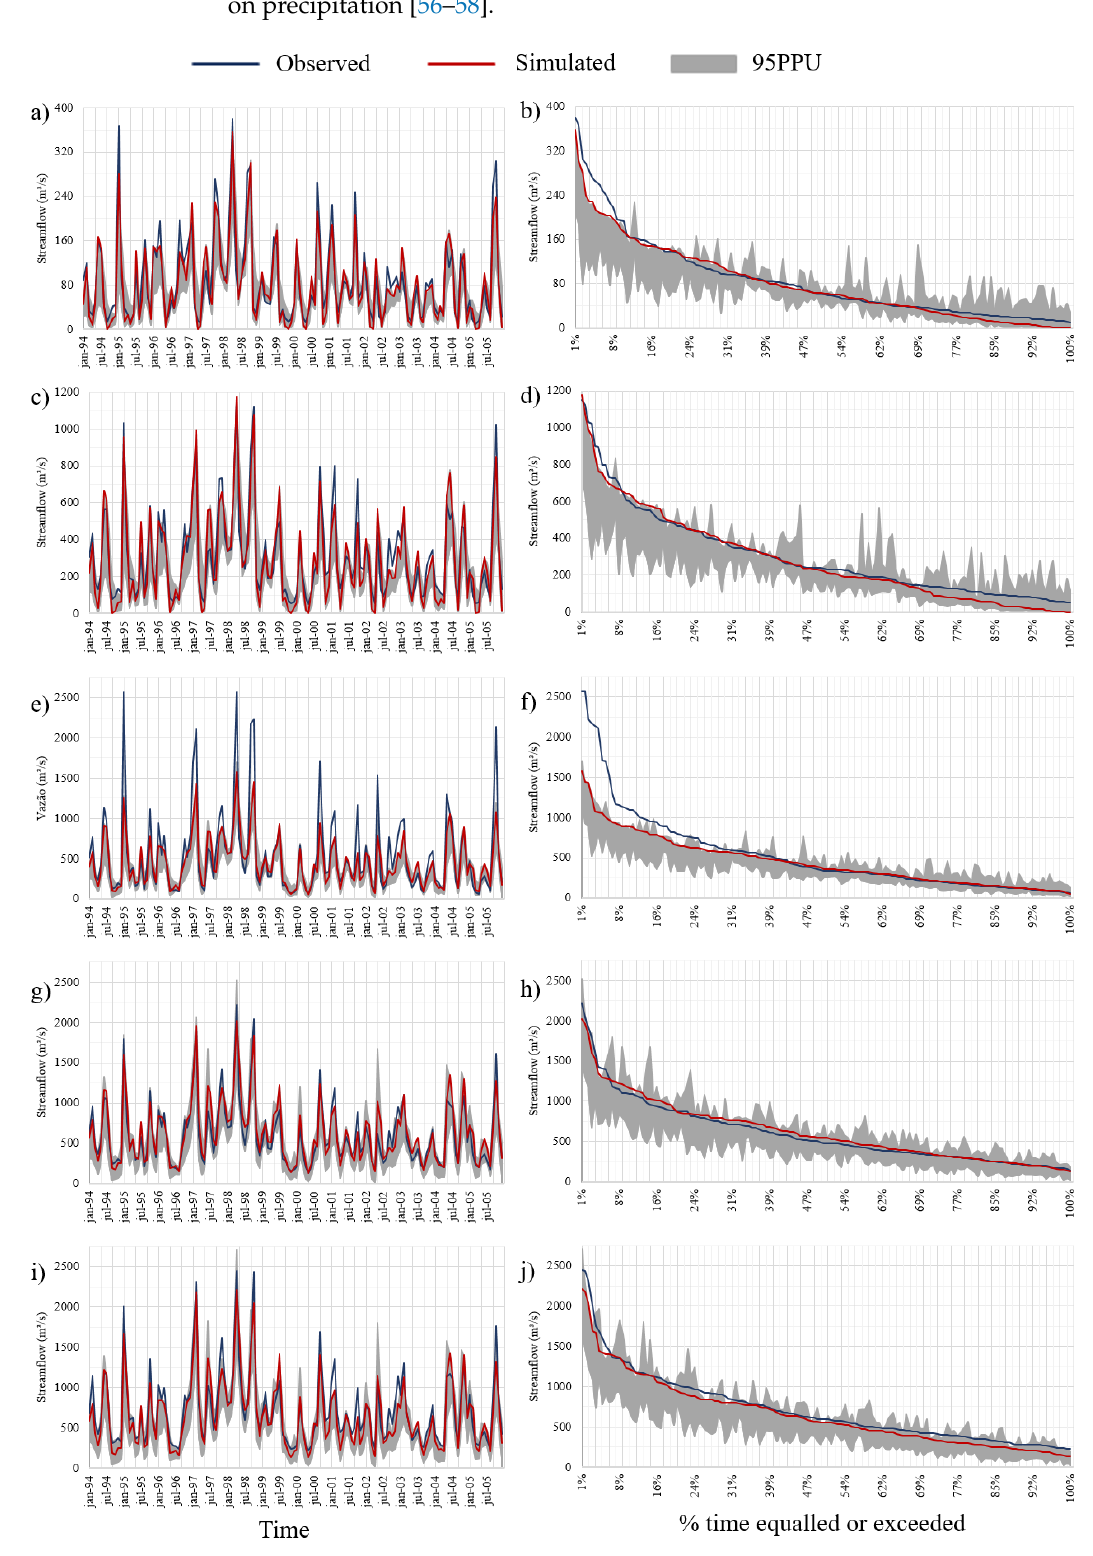
Figure 2. Simulated and observed hydrographs and respective flow duration curves for every monitoring station from IRB. From top to bottom: Tereza Cristina ( a , b ), Ubá do Sul ( c , d ), Vila Rica ( e , f ), Porto Paraíso do Norte ( g , h ), and Novo Porto Taquara ( i , j ).